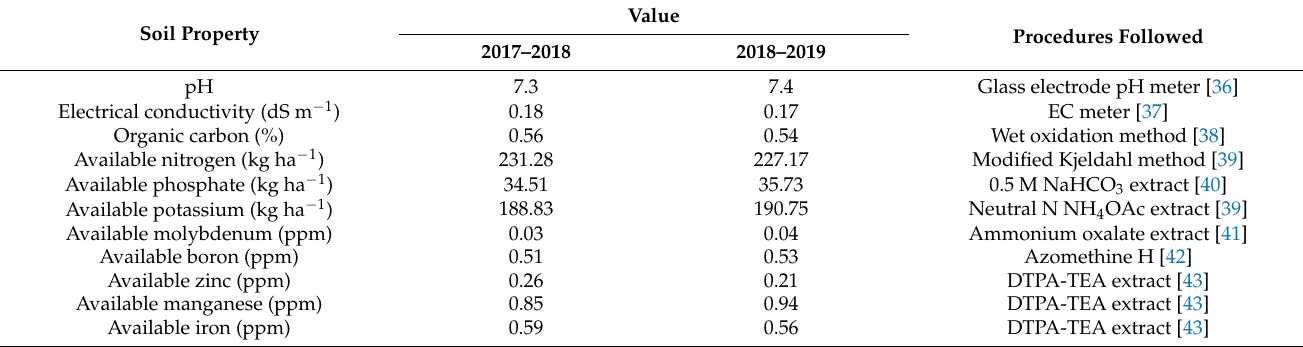
Table 1. Details of the experimental soil before